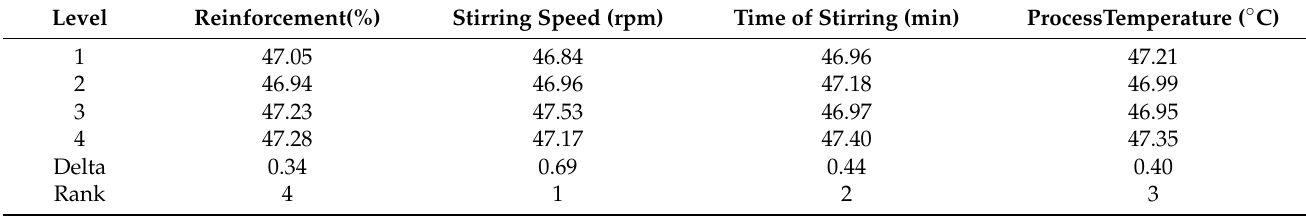
Table 10. Response table for signal to noise ratios (tensile strength).